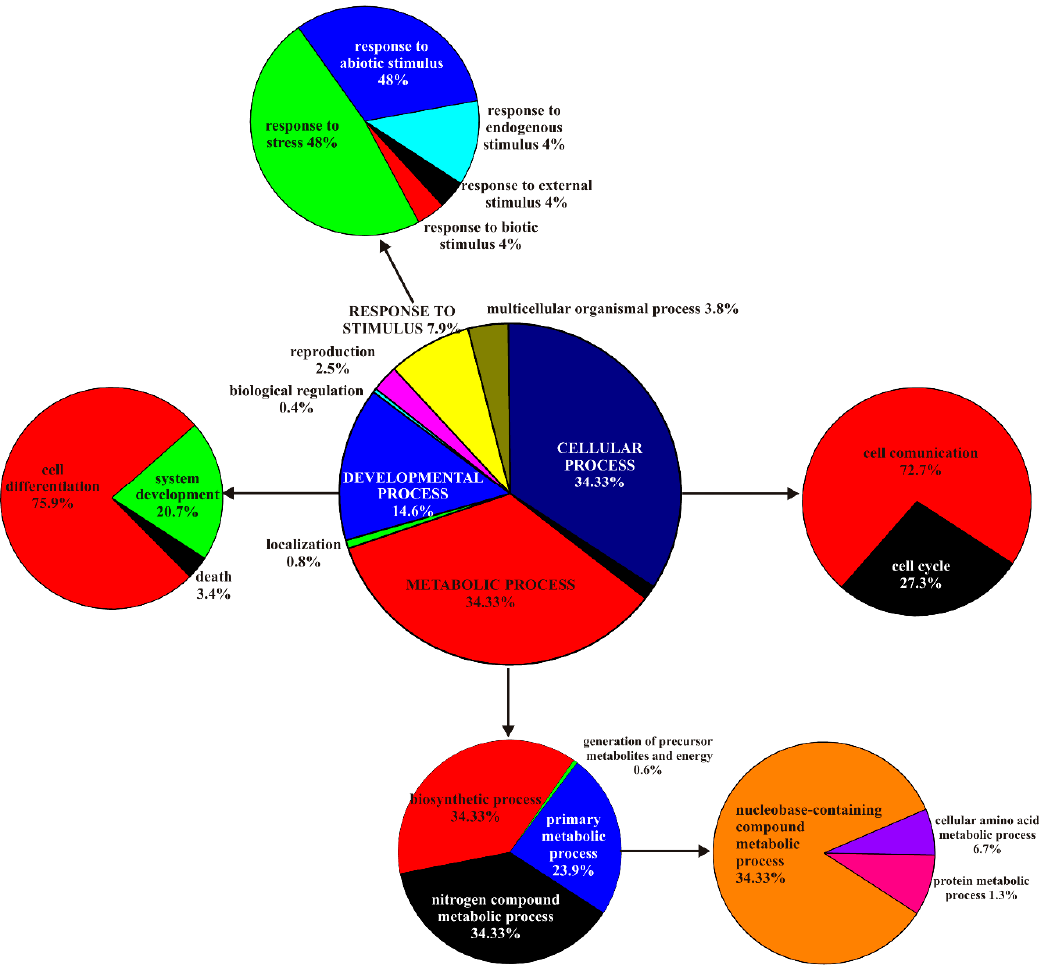
Figure 2. PANTHER biological process analysis based on gene ontology terms. Functional classification of genes encoding TFs predicted to interact with the promoter regions of MsrA and MsrB originating from the Arabidopsis thaliana , Populus trichocarpa , and Oryza sativa